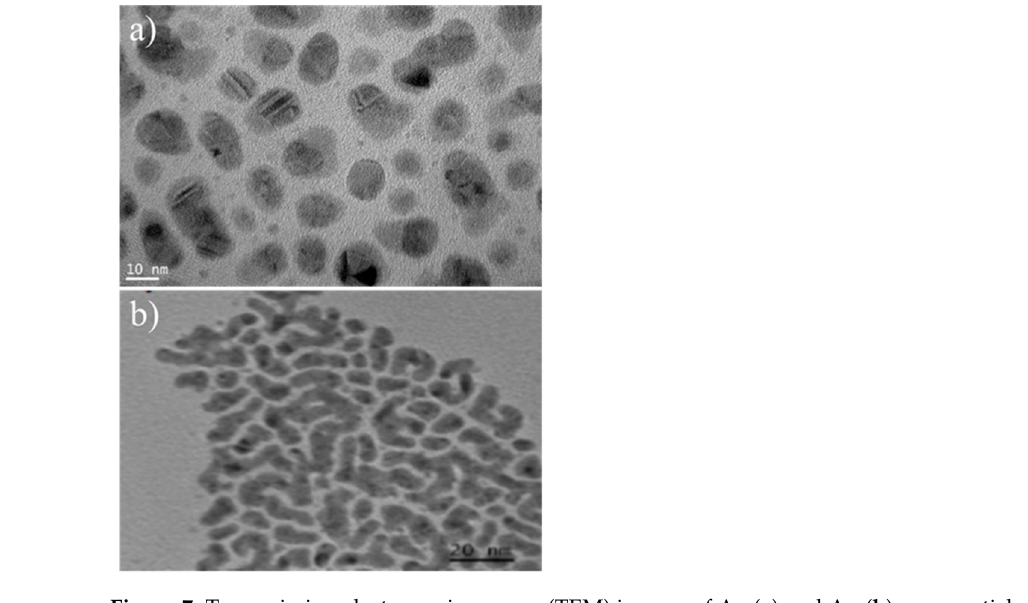
Figure 7. Transmission electron microscopy (TEM) images of Ag ( a ) and Au ( b ) nanoparticles.